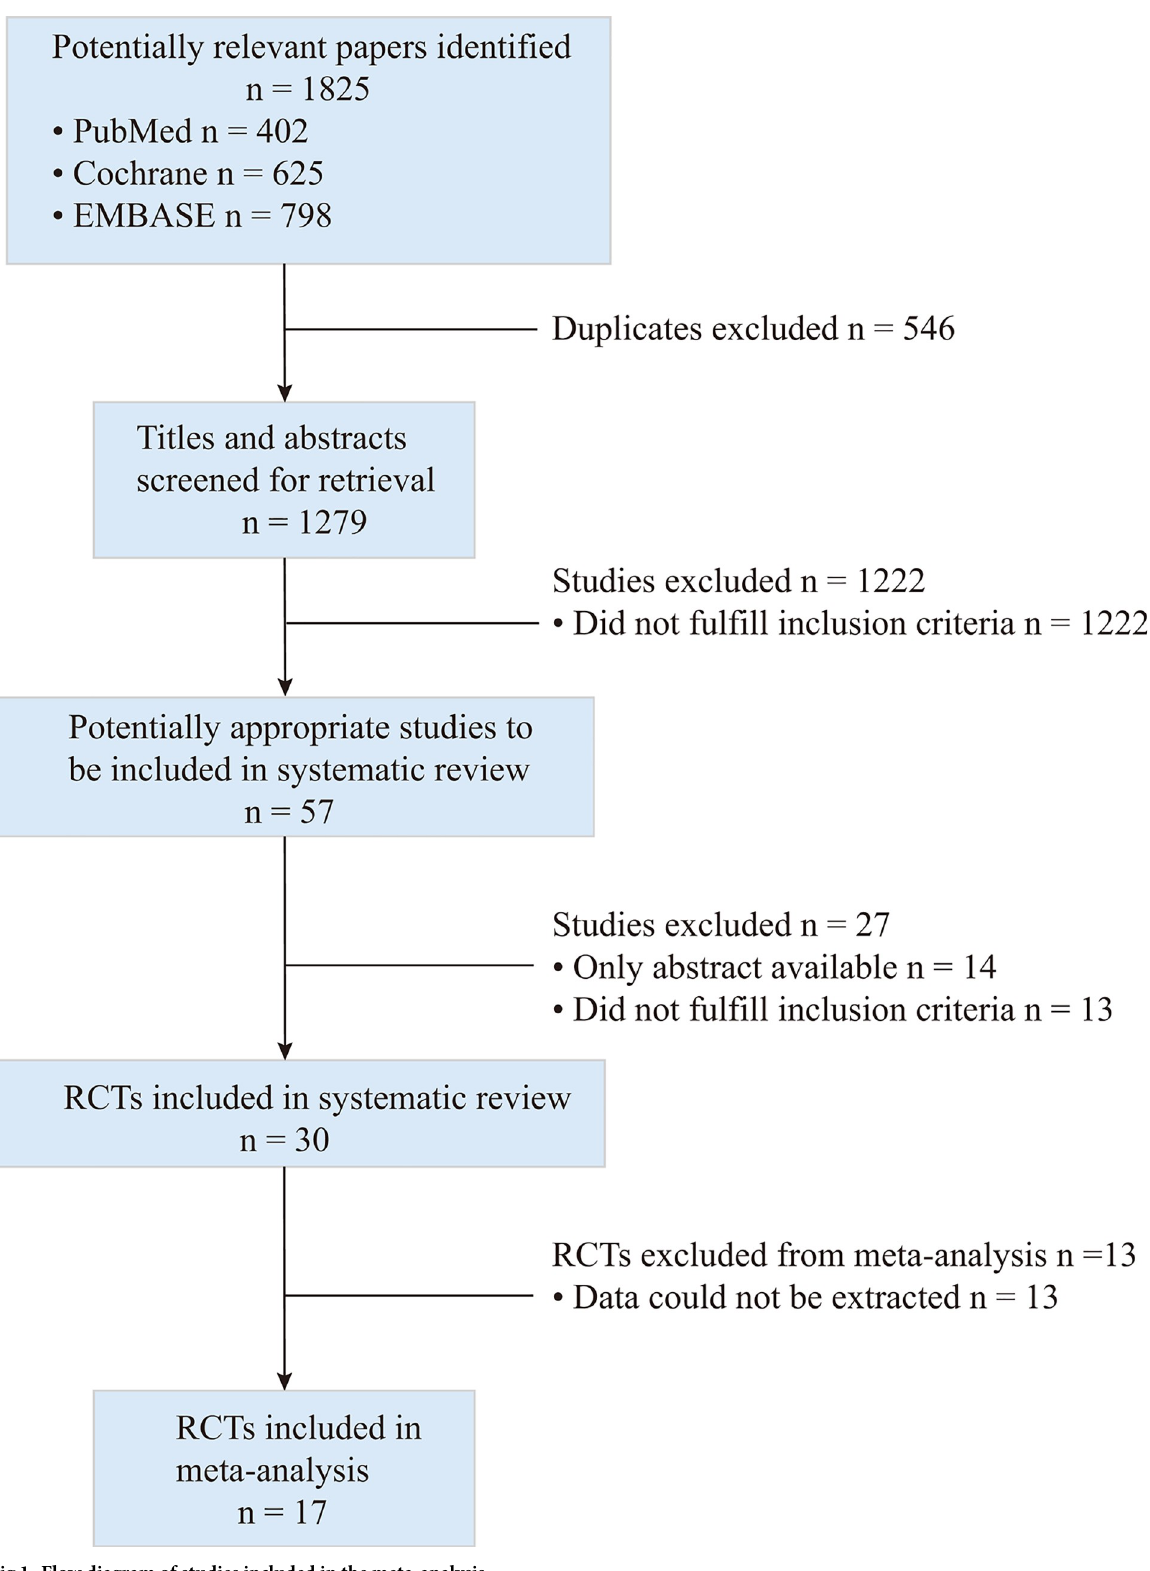
Fig 1. Flow diagram of studies included in the meta-analysis.